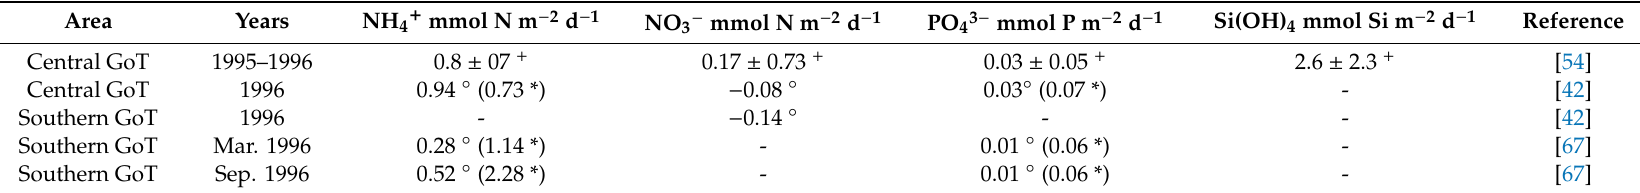
Table A4. Mean benthic fluxes (mmol m − 2 d − 1 ) of regenerated nutrients from marine sediments to the water column in oxic and anoxic conditions in the GoT.